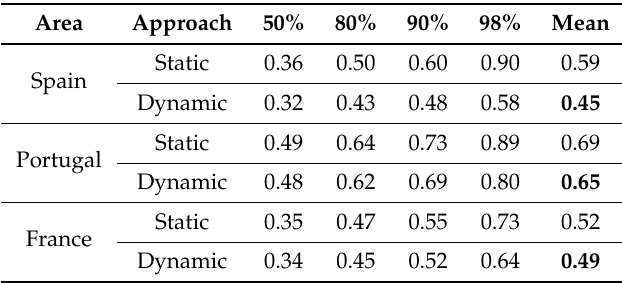
Table 4. Winkler score comparison on an hourly